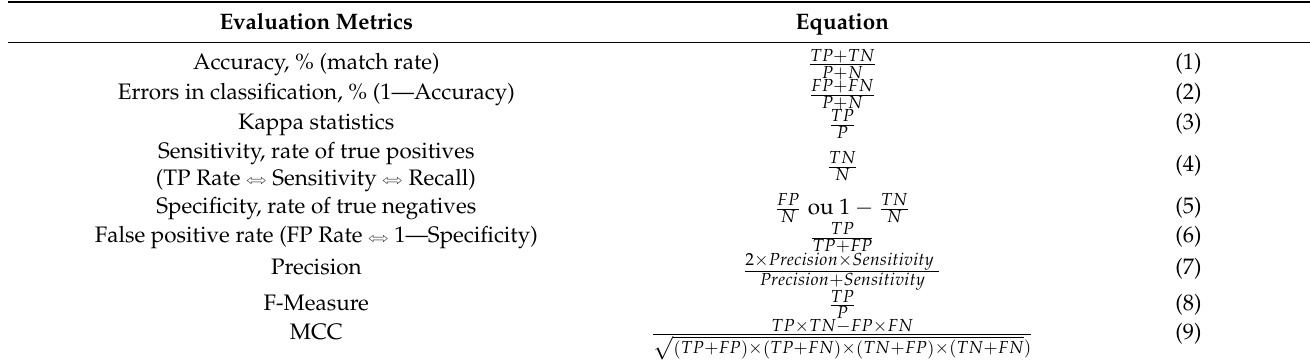
Table 4. The evaluation metrics and corresponding equations. Evaluation Metrics Equation